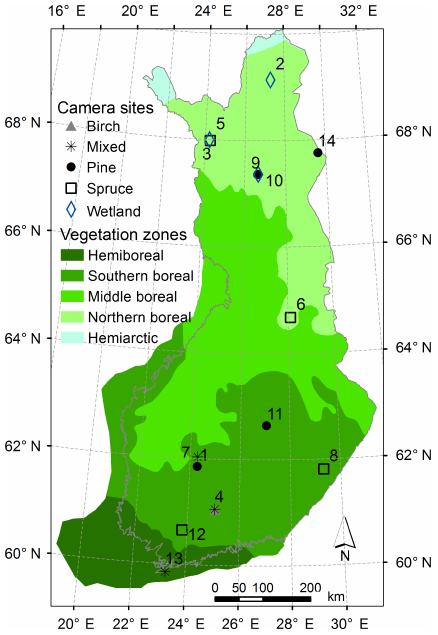
Figure 1. Sites in the phenological camera network, status end of 2016. Numbers refer to sites in Table 1. Data sources: Country bor- der © ESRI, Vegetation zones © SYKE,